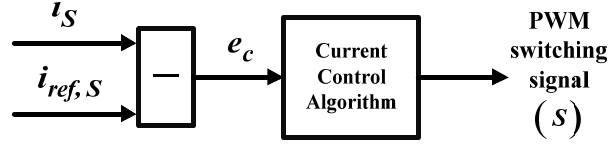
Figure 9. Conceptual model of an indirect current control (ICC) scheme.